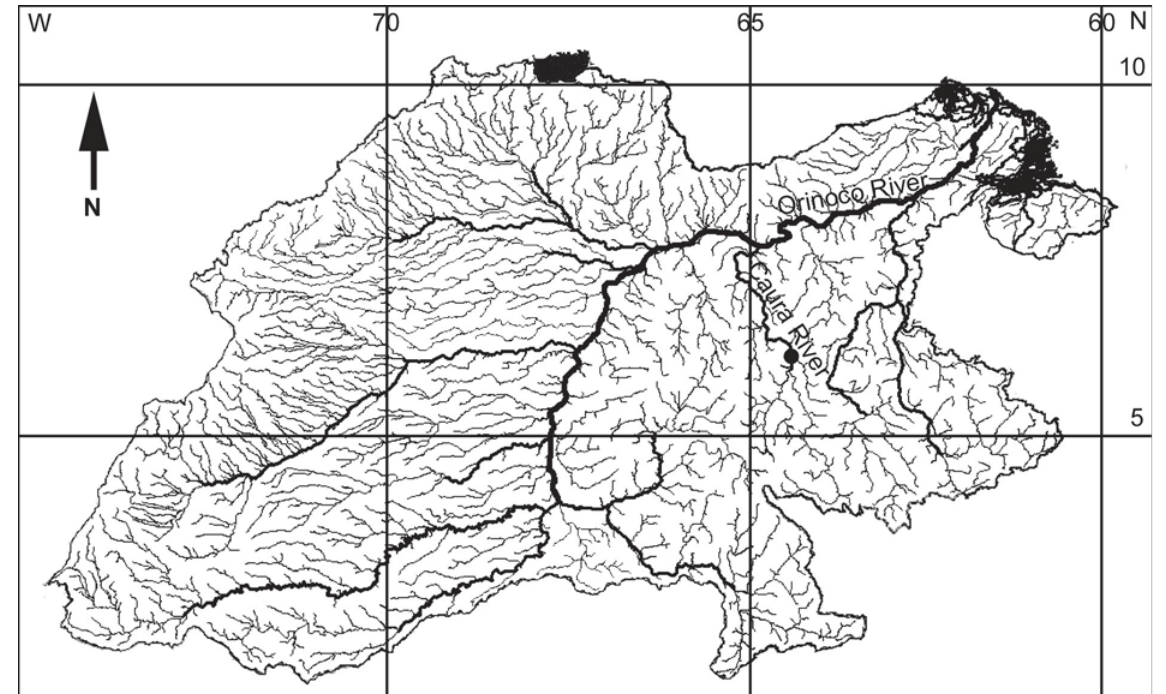
Fig. 3. Map of the Orinoco River drainage showing the type locality (solid circle) of Harttia merevari